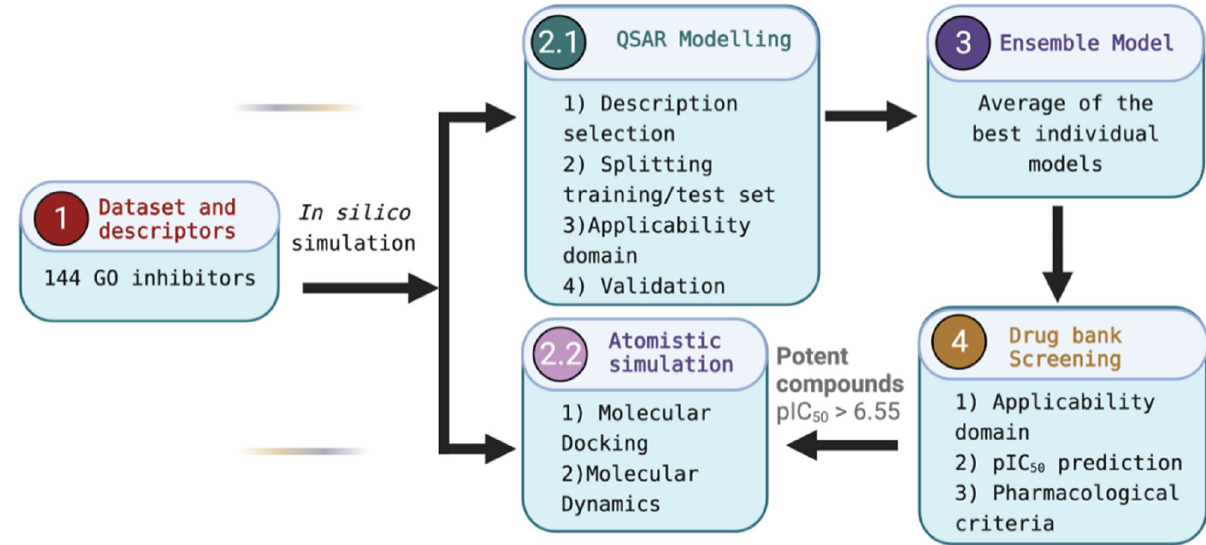
Figure 15. Flow diagram for the applied methodology in this